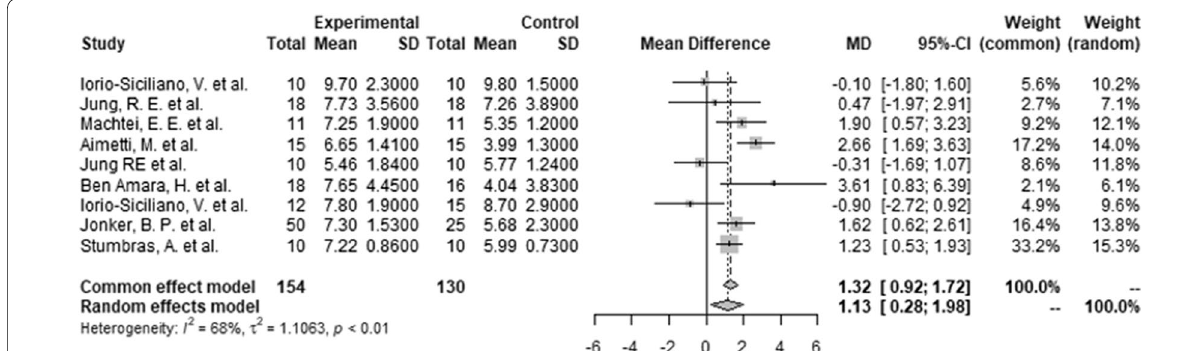
Fig. 3 Meta-analysis results for the primary outcome (bone crest in mm) for implant placement in a bone envelope throughout all the